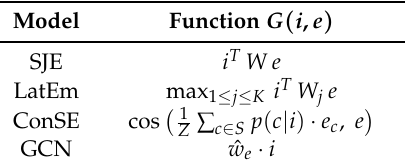
Table 1. Visual inference functions of baseline zero-shot recognition (ZSR)